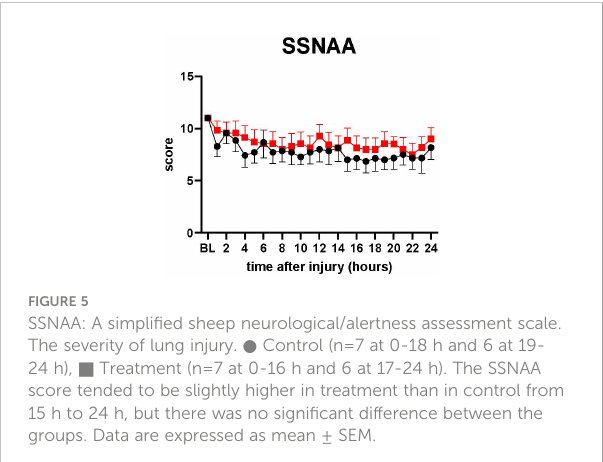
FIGURE 5 SSNAA: A simpli fi ed sheep neurological/alertness assessment scale. The severity of lung injury. ● Control (n=7 at 0-18 h and 6 at 19- 24 h), ■ Treatment (n=7 at 0-16 h and 6 at 17-24 h). The SSNAA score tended to be slightly higher in treatment than in control from 15 h to 24 h, but there was no signi fi cant difference between the groups. Data are expressed as mean ± SEM.